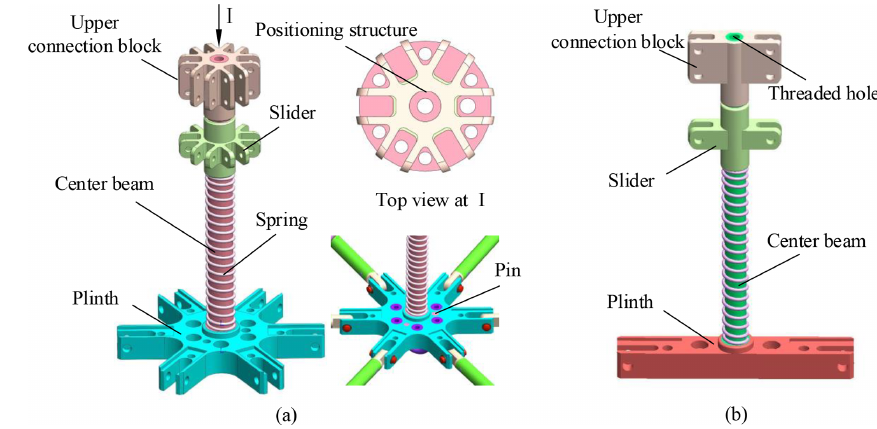
Figure 11. Central beam assembly. (a) Hexagonal central beam assembly. (b) The two-fold and three-fold